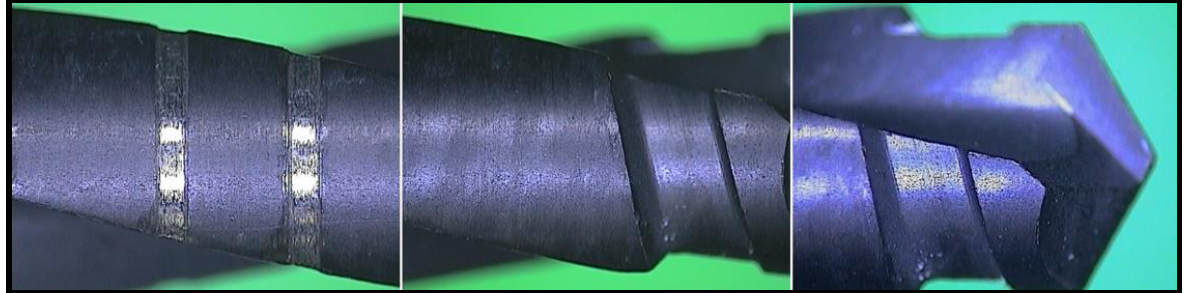
Figure 3. The whole drill was surveyed using 3D optical profilometer, and the wear roughness of drills was investigated on the widest part of the drill.